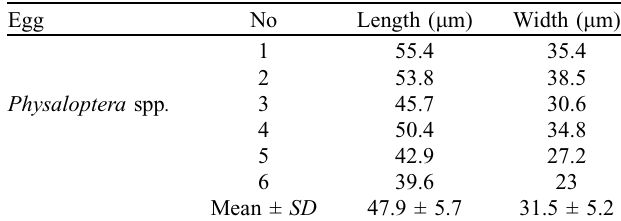
Table 1. Measurements of the identified